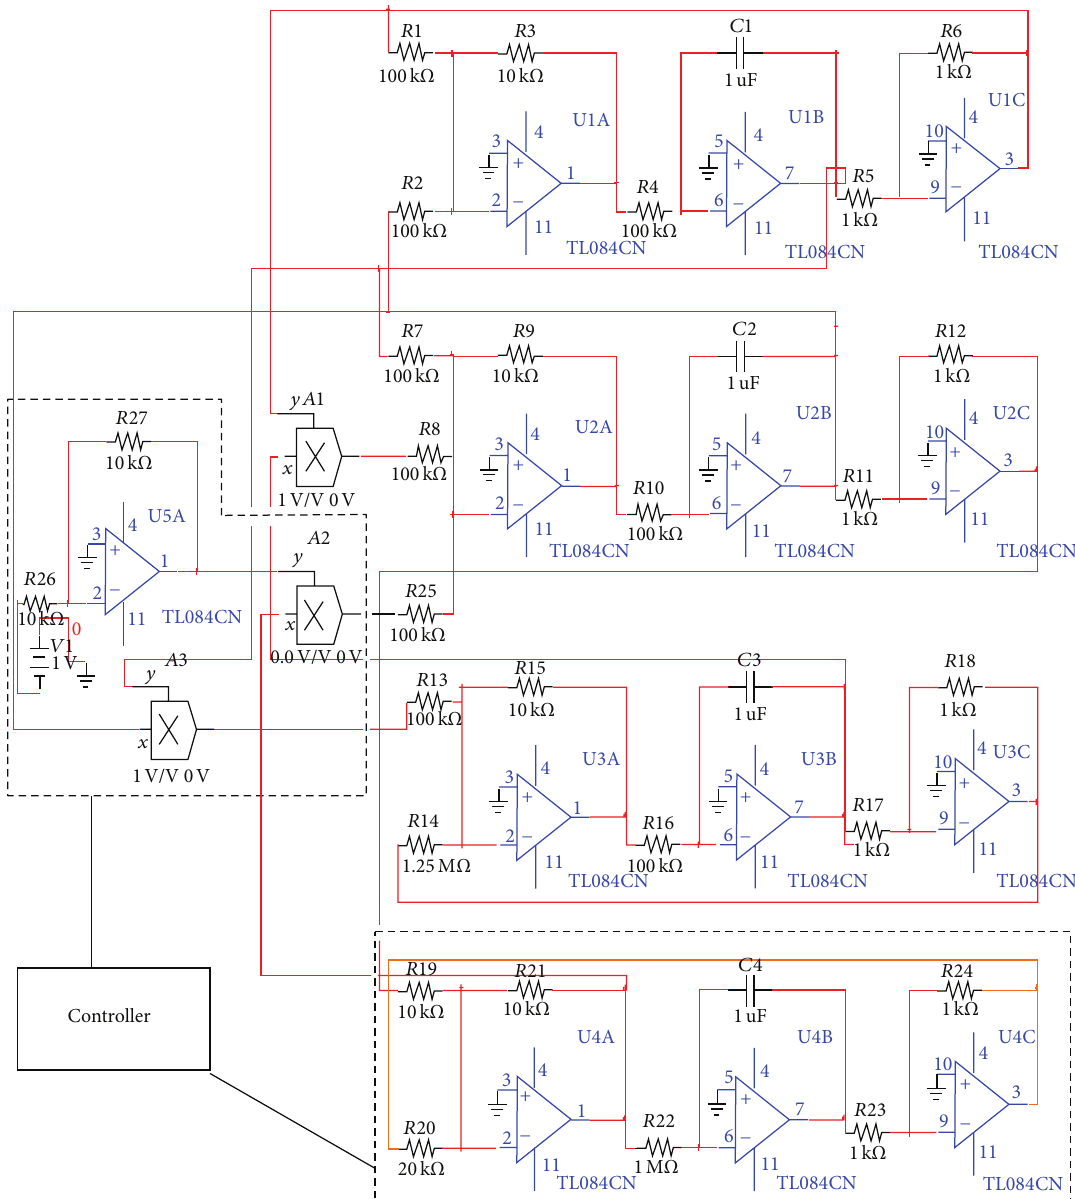
𝐵 (𝑞, 𝑞) = (0, 10.6 + 3.5𝑖, −0.1628 − 0.452𝑖, 0) 𝑇 , 𝐵 (𝑞, 𝑞) = (0, 1.55, −0.82, 0) 𝑇 , = (0.7975, 0.7975, 1.55, 1.595) 𝑇 , ℎ 11 ℎ = (−0.1567 + 0.5445𝑖, −1.627 + 0.1213𝑖, 20 0.2712 + 0.7712𝑖, −0.0644 + 0.5907𝑖) 𝑇 , ) = ( 0, 0.2 − 0.895𝑖, −0.24 + 0.96𝑖, 0 ) 𝑇 𝐵 (𝑞, ℎ 11